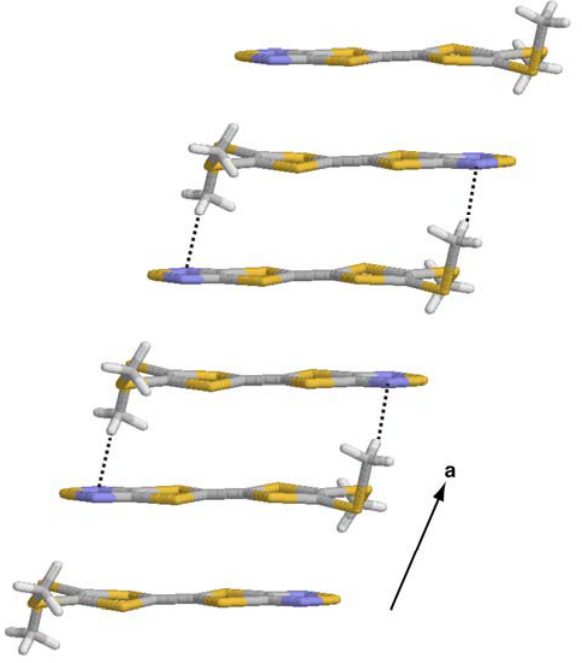
Figure 4. The stacking pattern of the dimer in the crystal structure of 1 . Dotted lines show